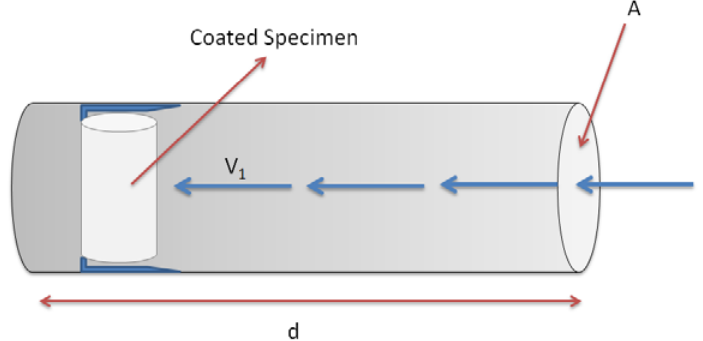
Figure 3. Experimental device for studying the effect of higher than critical solution velocities on the adhesion of coatings in concrete specimens.